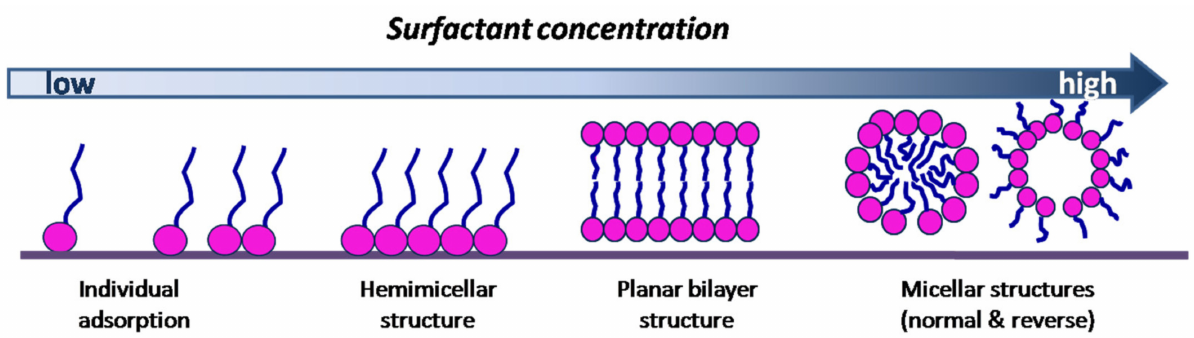
Figure 1. Concentration influence on typical surfactant structures at the water/oil (w/o)